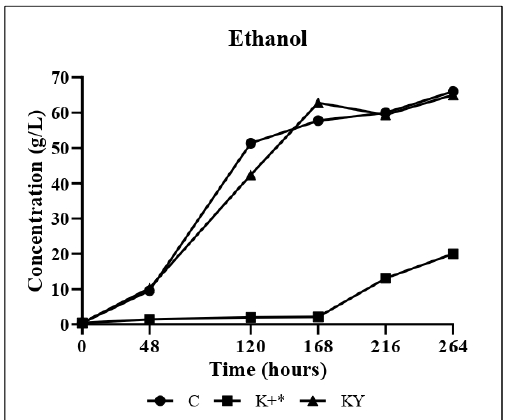
Figure 2. Ethanol production during 264 h of fermentation in the C, KY and K assays. C: Control, K: kombucha, KY: kombucha + commercial brewer yeast. *, Significant difference ( p < 0.05) between C and K assays; +, significant difference ( p < 0.05) between K and KY assays.